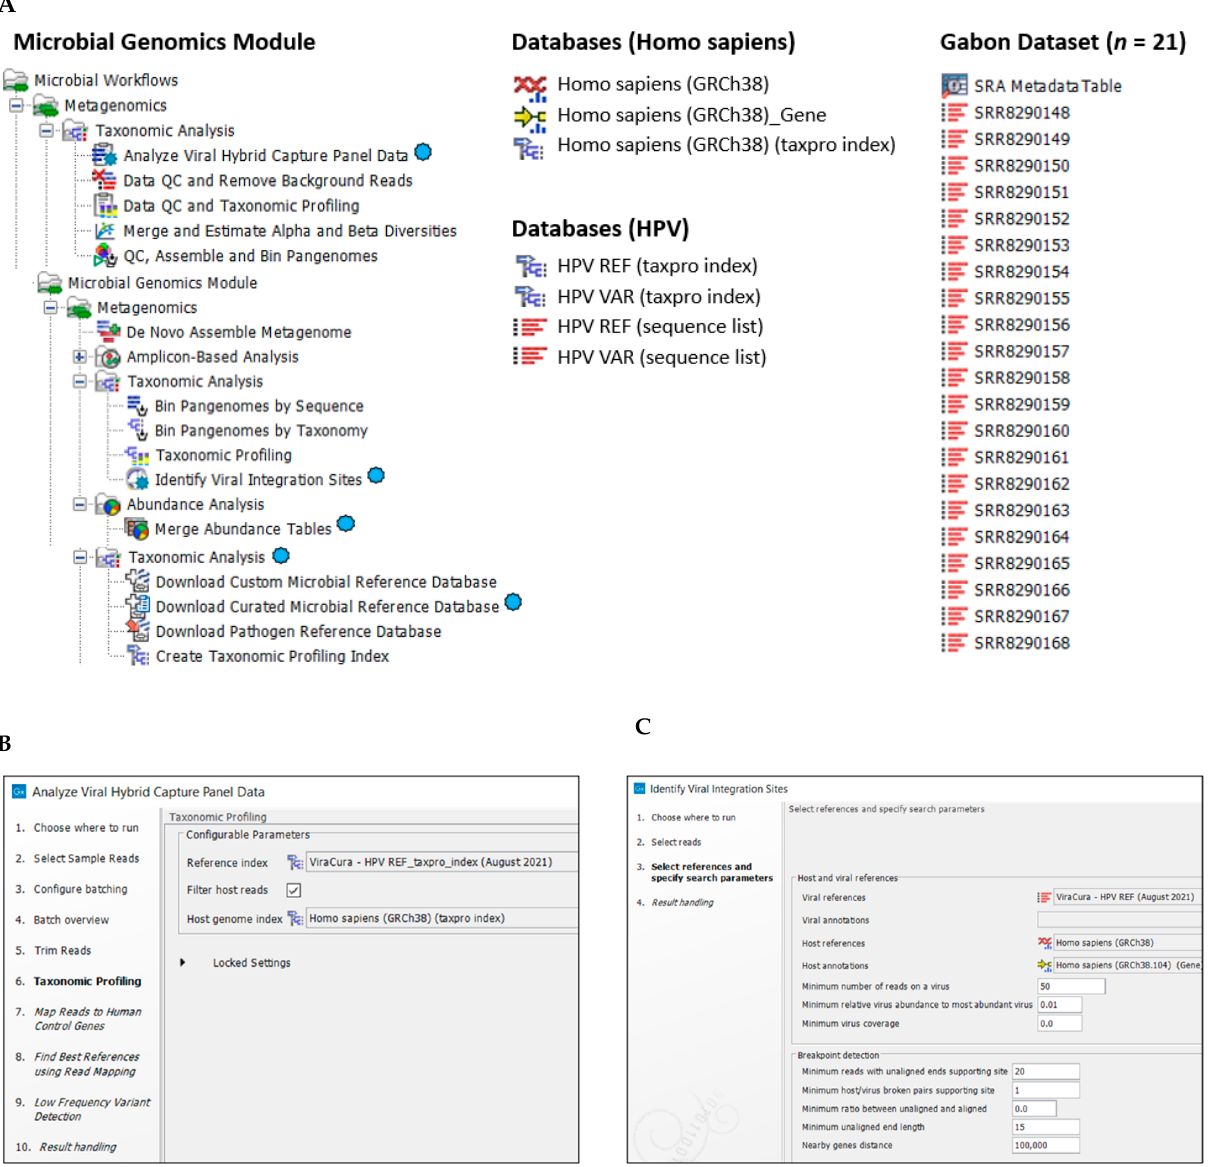
Figure 6. Bioinformatics methods ( A ) CLC Microbial Genomics Module, databases and dataset used for Viral Hybrid Capture (VHC) data analysis and Viral Integration Site (VIS) analysis. Primary workflows and tools used for this study are designated by the virus icon ( ); ( B ) VHC workflow steps (1–10) with user-defined parameter settings for Taxonomic Profiling (bold), i.e., HPV reference index and Host genome index; ( C ) VIS workflow steps (1–4) with selected HPV and Host reference genomes and user-defined search parameters entered for this study.